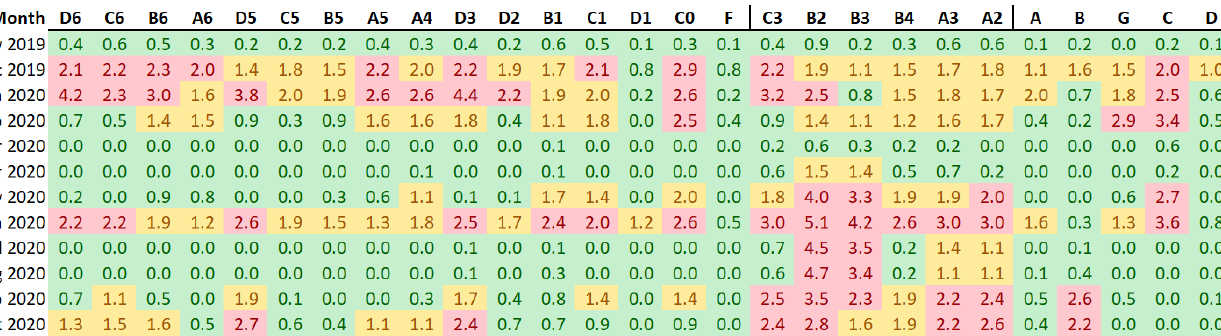
Figure 12. Number of out-of-band observations (i.e., values outside the security limits) for each data-logger computed by establishing the median band width (2.5 ◦ C, see Figure 10) as a common criterion for all data-loggers.